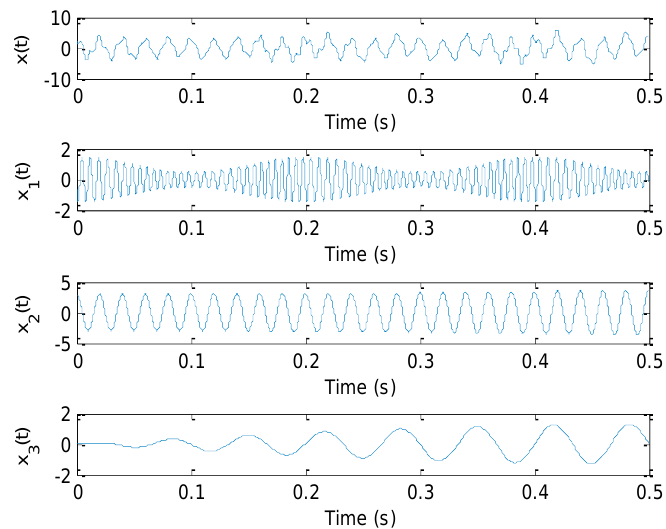
Figure 1. Waveform of the simulated signal and its components.